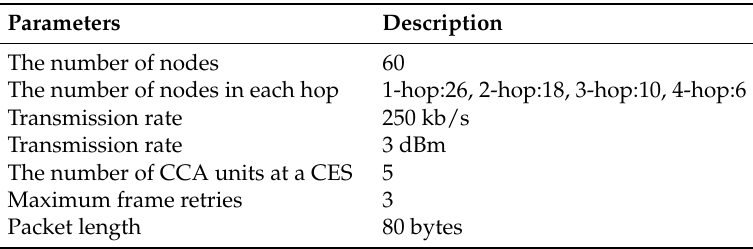
Table 3. Experiment